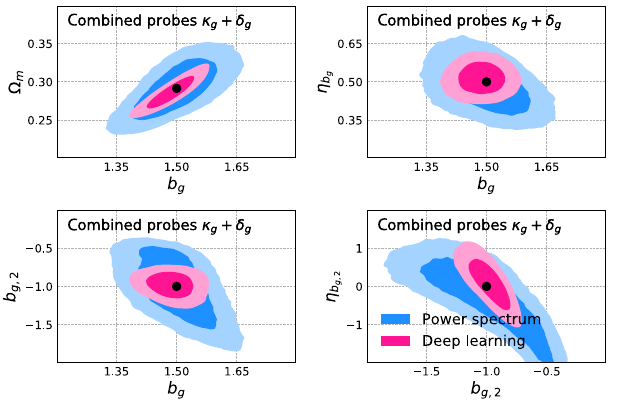
FIG. 5. Galaxy bias constraints for the nonlinear bias model for combined probes. Deep-learning results are shown in pink, while power spectra are shown in blue. To give some intuition about the meaning of the η parameter, we calculated its uncertainty using b g (cid:2) ¼ 0 . 21 bias measurements from DES Y3 [7] and obtained σ ½ η b g